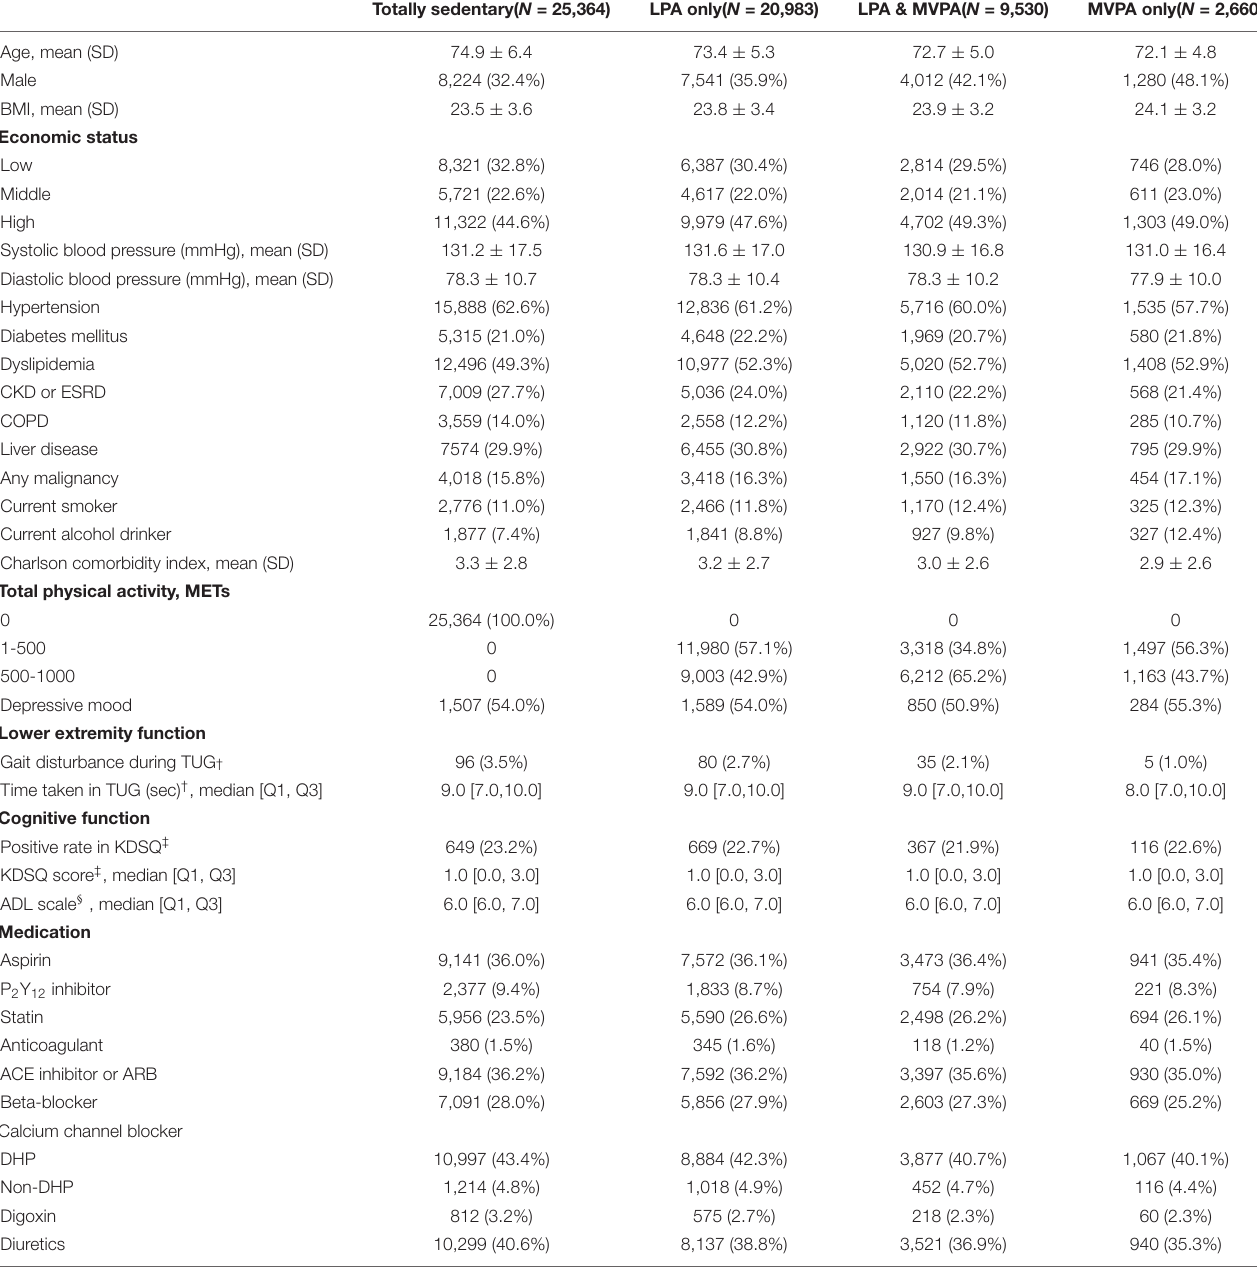
TABLE 1 | Baseline